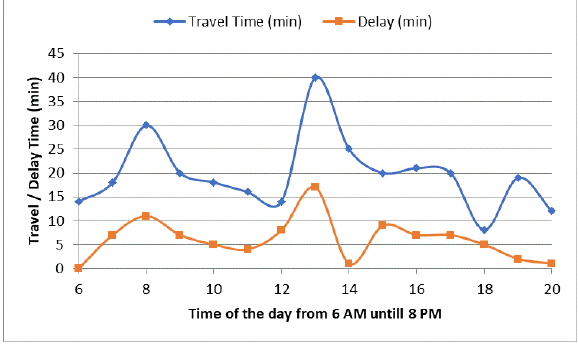
Fig. 1. Travel time and Delay of buses in the 6 th ring